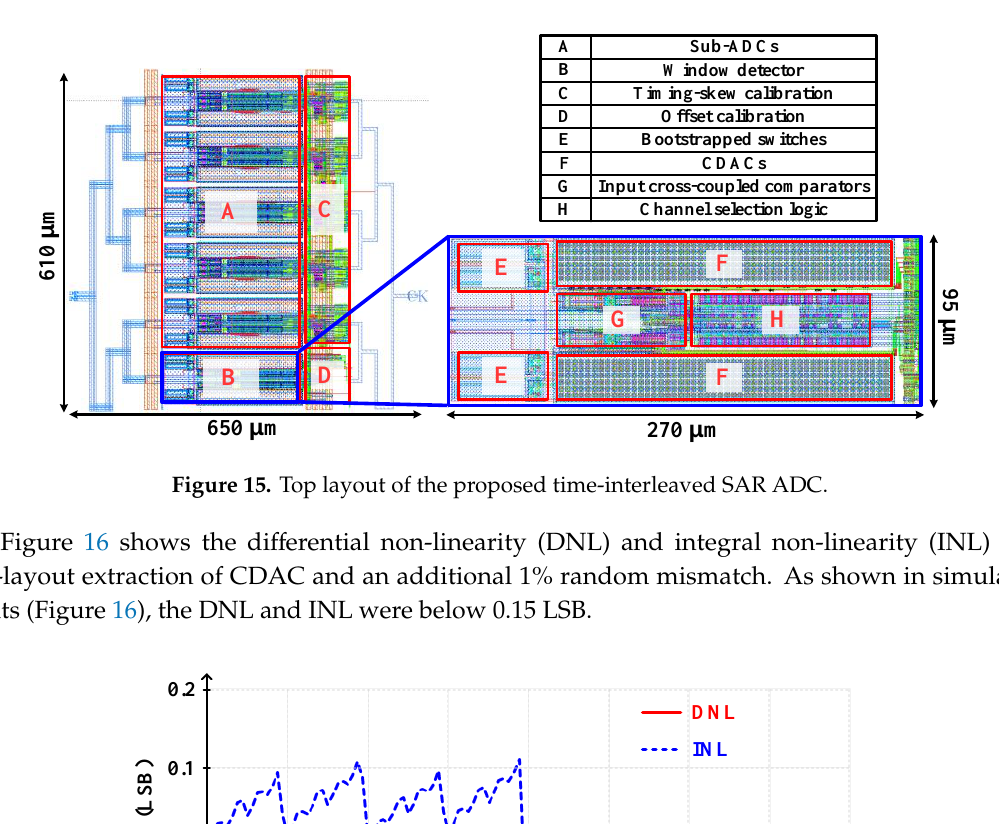
Figure 17. The offset calibration convergence for differential-difference comparators (DDCs). Figure 18 shows the coarse-fine offset calibration convergence for window detecting comparator, and its corresponding forced offset voltage. To force 15 mV offset, the ~8.5 mV coarse calibration was performed first, followed by ~1.5 mV fine calibration. As the calibration progressed, the offset voltage was forced to ~15 mV corresponding to 1 LSB. Thus, the window width was set to 2 LSB (±15 mV) In the case of the sub-ADC, Ch.1 and Ch.2 had +23 ps and -20 ps timing skews, respectively, the timing-skew calibration convergence is described in Figure 19. The coarse calibration was performed first with ~3 ps accuracy, followed by fine calibration with ~1 ps accuracy. The total calibration range was ~±28 ps. In total, five sub-ADCs were calibrated, but due to lack of space, we only report two simulation results in this paper.